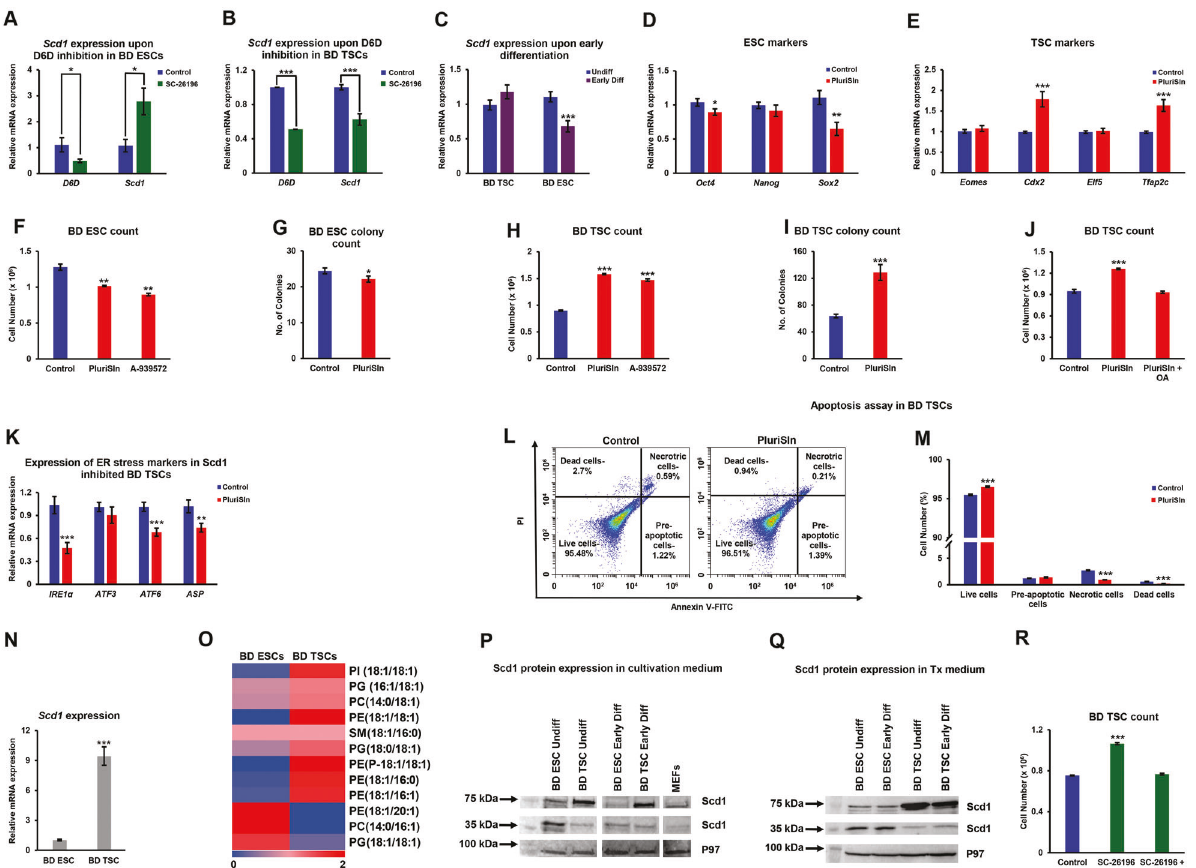
Fig. 5 D6D regulates Scd1 expression, essential for ESCs, but deleterious for TSCs. The expression of Scd1 in feeder free culture following 48 h of inhibition of D6D (0.2 µM SC-26196), or in DMSO-treated control cells, was evaluated by RT-qPCR in undifferentiated ESCs ( A ) and TSCs ( B ) (both 129/black 6 background). Scd1 expression was also assessed in early differentiating ESCs and TSCs, compared to their undifferentiated counterparts ( C ). The in fl uence of Scd1 on pluripotency ( D ) or TSC ( E ) markers in early differentiating SCs, as well as on cell viability ( F – J ) was evaluated following treatment with Scd1 inhibitors [PluriSIn 1 (20 µM) or A939571 (300 nM)] or DMSO vehicle for 48 h. Conjugated oleate (100 µM) was added to PluriSin 1-treated TSC culture J . The expression of IRE1 α , ATF3 , ATF6 , and ASP was assessed by RT- qPCR following inhibition of Scd1 by PluriSIn 1 for 48 h ( K ), and concomitant apoptosis was evaluated using an Annexin V-FITC/PI-based kit ( L , M ). The relative expression of Scd1 in self-renewing ESCs and TSCs was evaluated by RT-qPCR ( N ). Monounsaturated fatty acyl chain phospholipids were identi fi ed and quanti fi ed in self-renewing TSCs and ESCs by LC-MS. The abundance of each metabolic feature was normalized to the sum intensity of peaks of each chromatogram. The colors of quadrants in the heat maps represent the relative abundance of the metabolites, after normalization to the mean abundance of each lipid across all samples ( n = 6; O ). Scd1 protein expression was determined by Western blot analysis (10% acrylamide gel) in self-renewing ESCs and TSCs in ESC cultivation medium or Tx medium, respectively ( P ), or for both cell types in the same de fi ned Tx medium ( Q ). TSC proliferation was evaluated following incubation with PluriSIn 1 or PluriSIn 1 + conjugated oleate (100 µM) ( n = 4; R ) Data are presented as mean ± SEM. n = 4. * P < 0.05; ** P < 0.01; *** P <